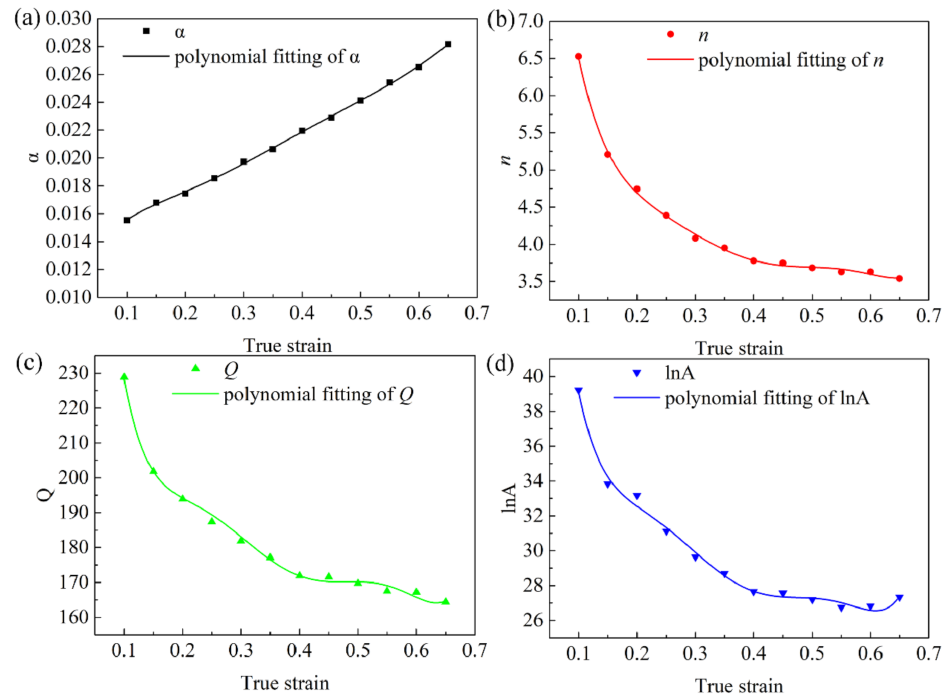
Figure 5. Plots of the compensation functions of different material parameters: ( a ) a, ( b ) n, ( c ) Q, and ( d )